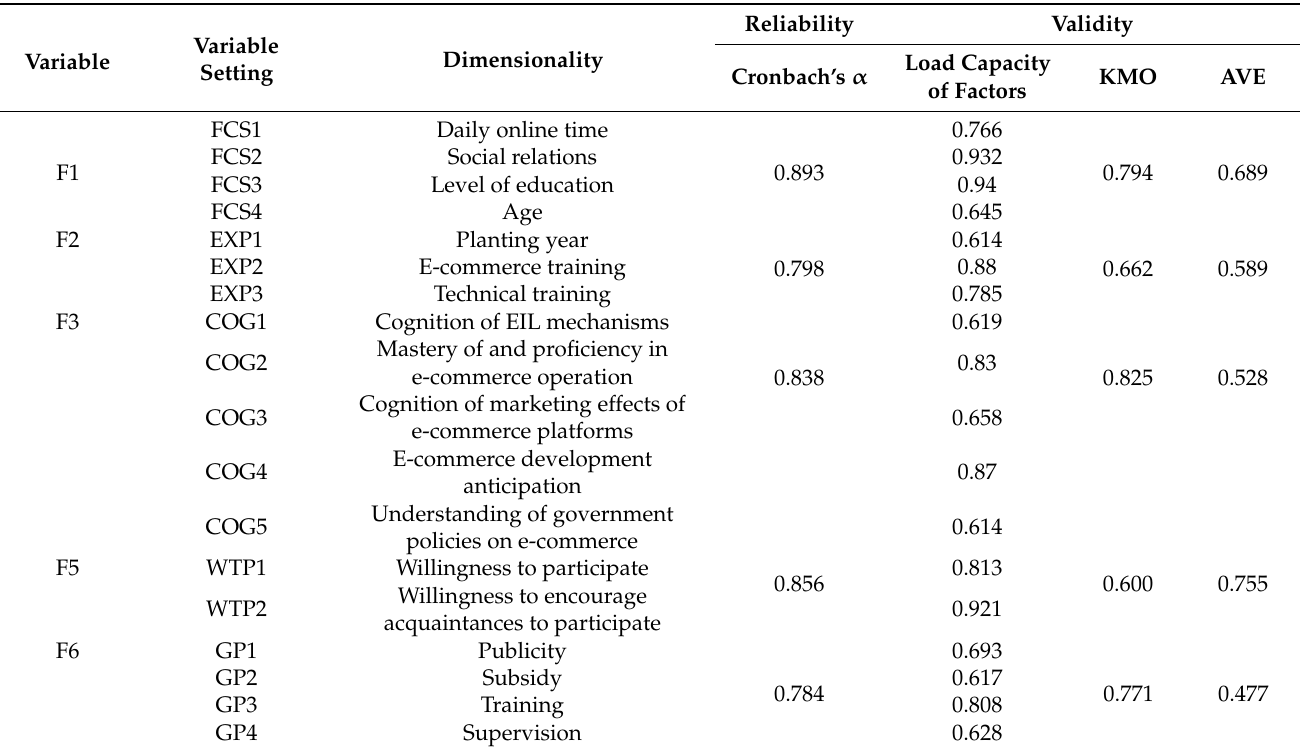
Table 7. Reliability and validity